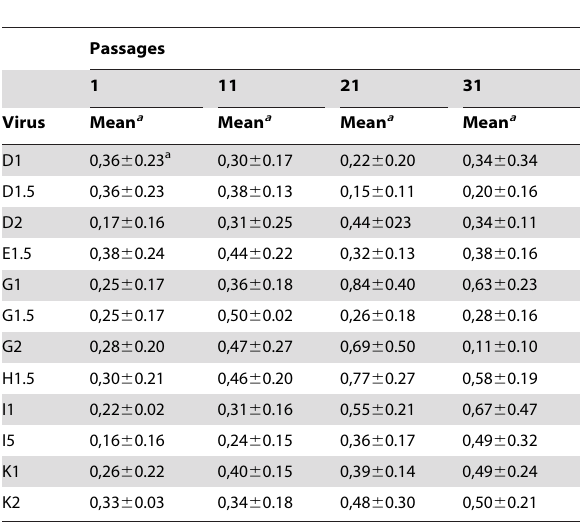
(Table 2); finally, one of the virus ( K2 ) was not able, after the